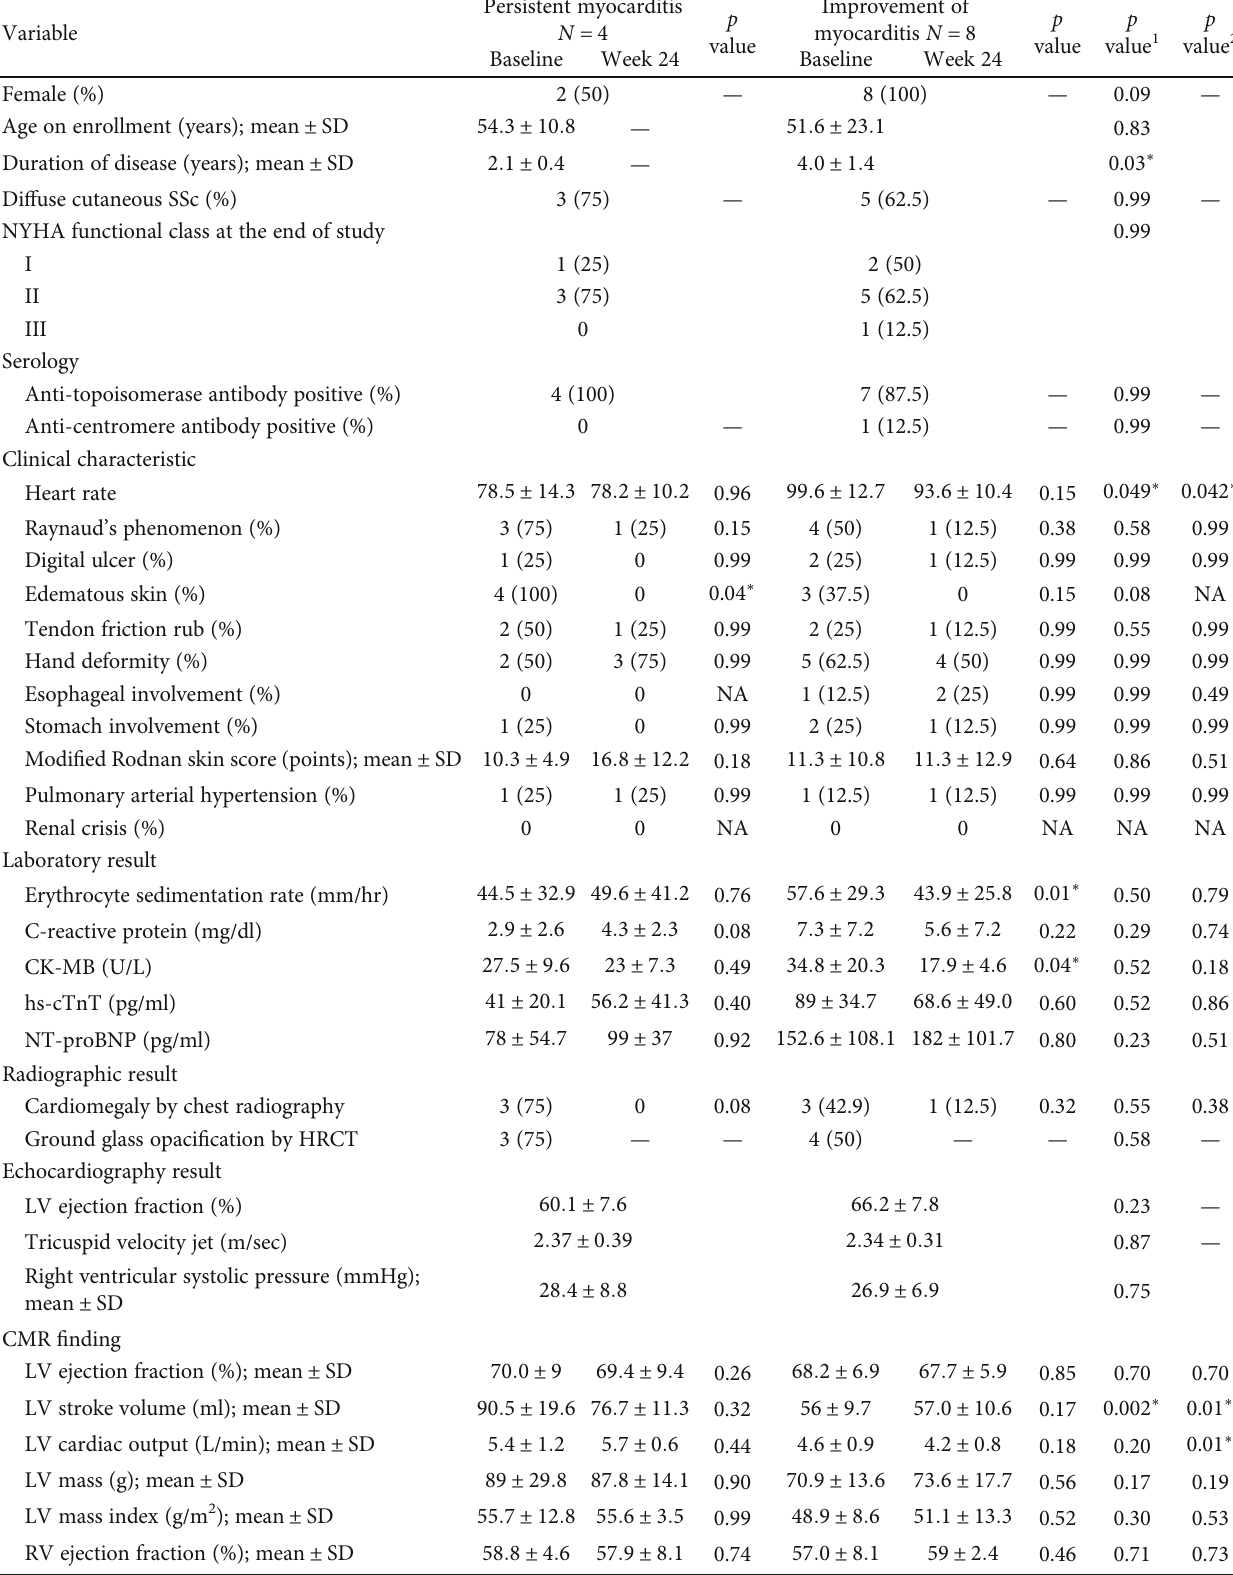
Table 2: Clinical characteristics at baseline and week 24 after treatment in those who had improvement of myocarditis vs. persistent